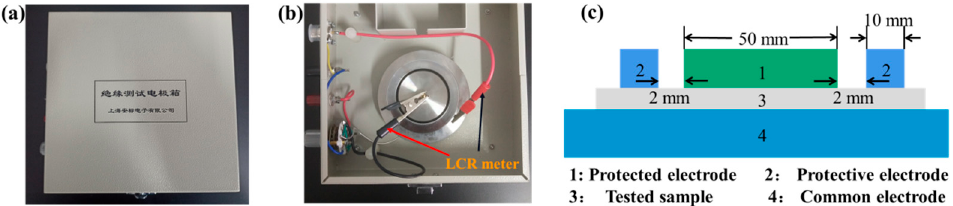
Figure 4. The three-electrode measurement system. ( a ) Exterior diagram of the test system. ( b ) Interior diagram of the test system. ( c ) Sectional diagram.